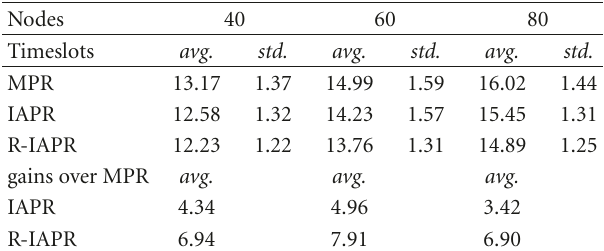
Table 2: Average timeframes of MPR, IAPR, R-IAPR routing schemes, and average performance gains of the pruning